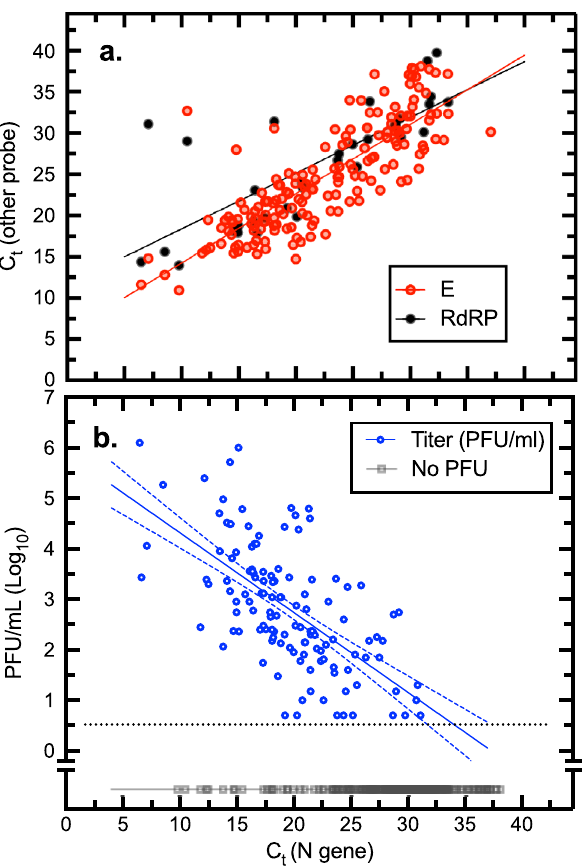
Figure 2. SARS-CoV-2 detection using PCR and plaque assays. ( a ) Comparison of reverse transcriptase qPCR assays. At the mid-point of the plot, the N gene-based assay generates C t values that are about two values lower that C t measured using E or RDRP gene primers. The solid lines were calculated from a linear regression (y = 0.84x + 5.9, goodness of fit r 2 = 0.67; y = 0.68 + 11.6, goodness of fit r 2 = 0.59) for E and RdRP assays, respectively. ( b ) Relationships between N gene-based C t values and virus titer measured as plaque forming units (PFU). The samples exhibited a wide range of virus titers varying from > 10 6 PFU/mL to the limit of detection (~ 5 PFU/mL). A linear regression fitted to the log 10 -transformed data is also shown (y = − 0.16x + 5.9; r 2 = 0.41) along with the 95% confidence intervals. Specimens bearing no detectable infectious SARS-CoV-2 virus are also plotted for purposes of comparison (black squares). Most of the specimens (97%) were titered on Vero CCL-81 cells. Figure prepared using Prism v9.3 (https:// www. graph pad.